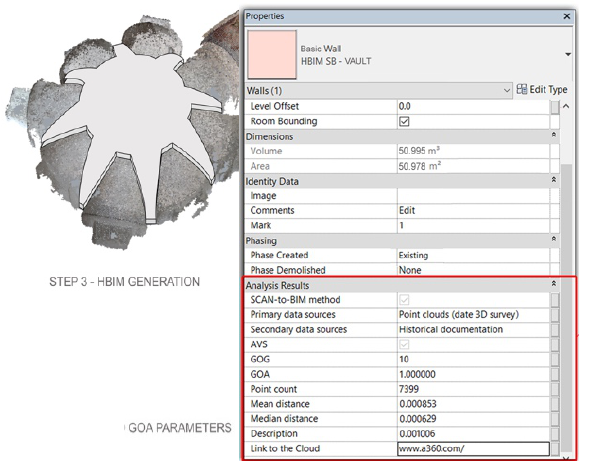
Figure 7. Step – 3 HBIM generation: transformations of the NURBs model into a parametric